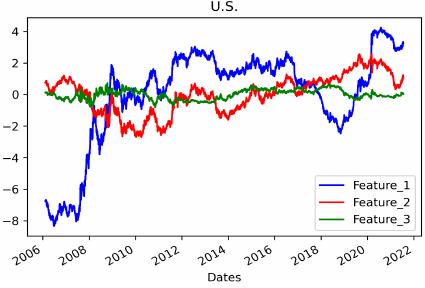
Figure 7. Features of US term